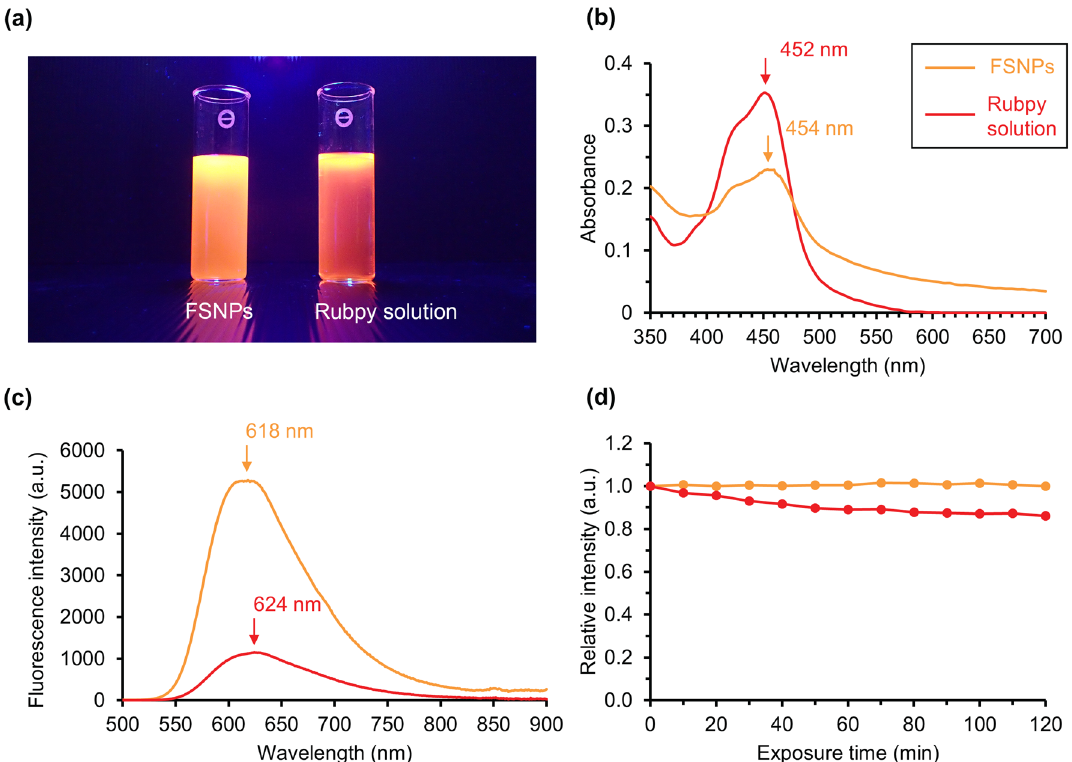
Figure 2. ( a ) Orange luminescence of FSNP suspension and Rubpy dye solution under UV light, ( b ) absorption spectra of 0.1 mg/mL FSNPs and 0.027 mM Rubpy dye solution, ( c ) emission spectra of 1 mg/mL FSNPs and 0.27 mM Rubpy dye solution when excited with 460 nm excitation band, and ( d ) fluorescence stability of 1 mg/ mL FSNPs suspension compared to 0.27 mM Rubpy dye solution after being exposed to a 150 W mercury vapor lamp for 2 h. Arrows indicate maximal absorption or maximal emission wavelengths.